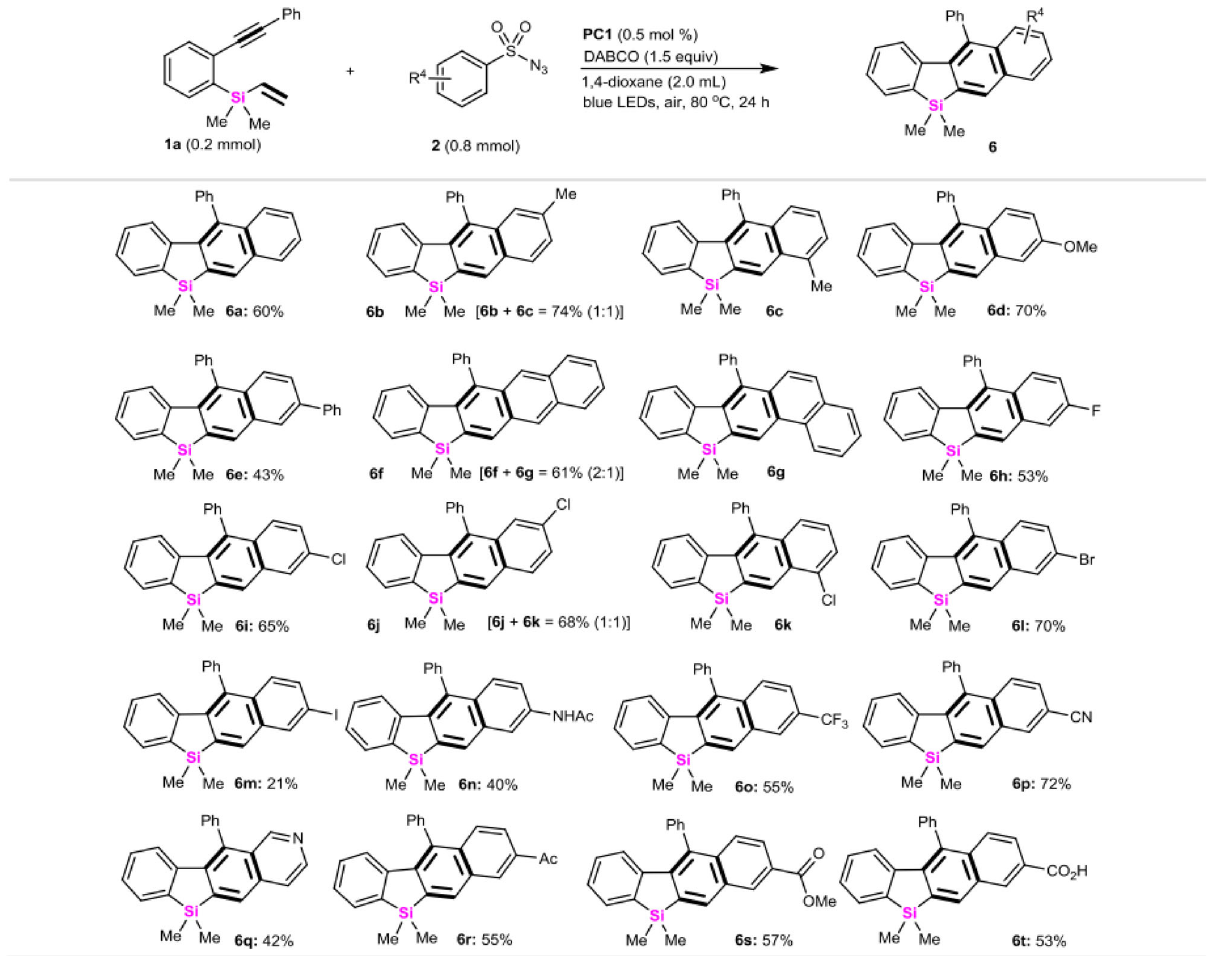
Fig. 5 Arylsulfonylazide scope. All the reactions are conducted in sealed tubes, followed by fl ash chromatography on SiO 2 . The isolated yields are reported and ratios of isomers are shown in